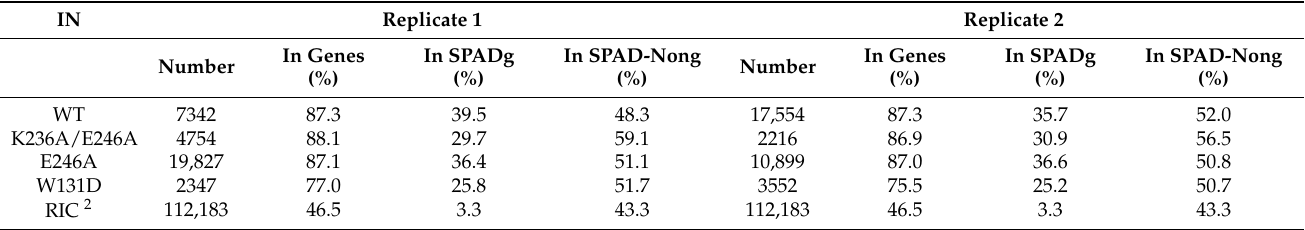
Figure 6. Class II IN mutant viral infectivities and genic integration targeting frequencies. ( A ) IN mutant HIV-Luc infection levels (average ± standard deviation from two independent experiments; within each experiment, luciferase values were determined for technical triplicate samples) were percent normalized to WT HIV-Luc, which was set to 100%. *, p < 0.01 (also see Table S1). ( B ) Percent integration in RefSeq genes in HEK293T cells for the infections shown in panel A; replicate 1 data is plotted to the left. Asterisks show differences versus matched RIC (red) and WT HIV-Luc (black) controls. ***, p < 0.0001—see Table S5 for detailed statistical analyses. Table 4. Integration sites of class II IN mutant viruses 1 .